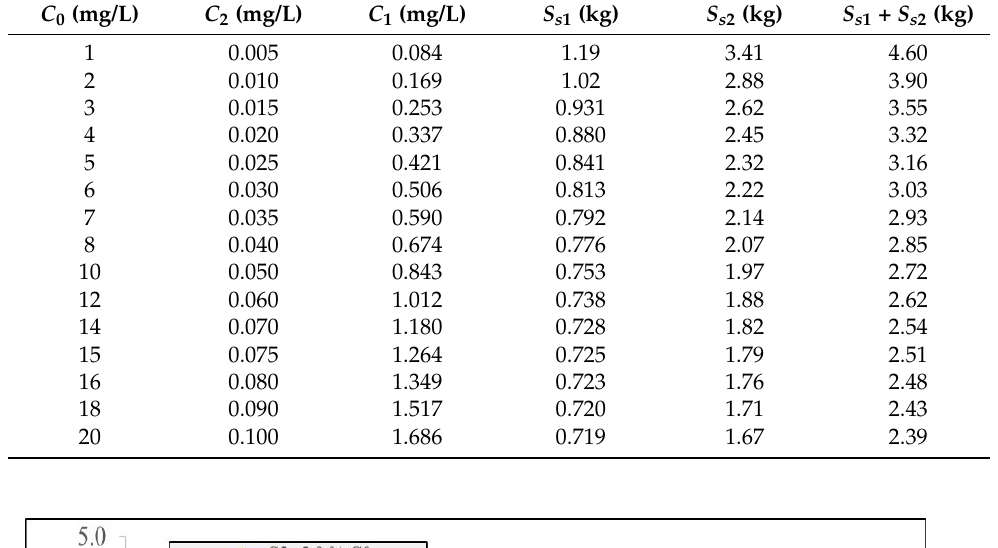
Table 5. Minimum total quantity of phosphoric-acid-treated date stone activated carbon to remove IBU using the Langmuir–Freundlich model to achieve C 2 = 0.5% C 0 for 1000 L of solution.